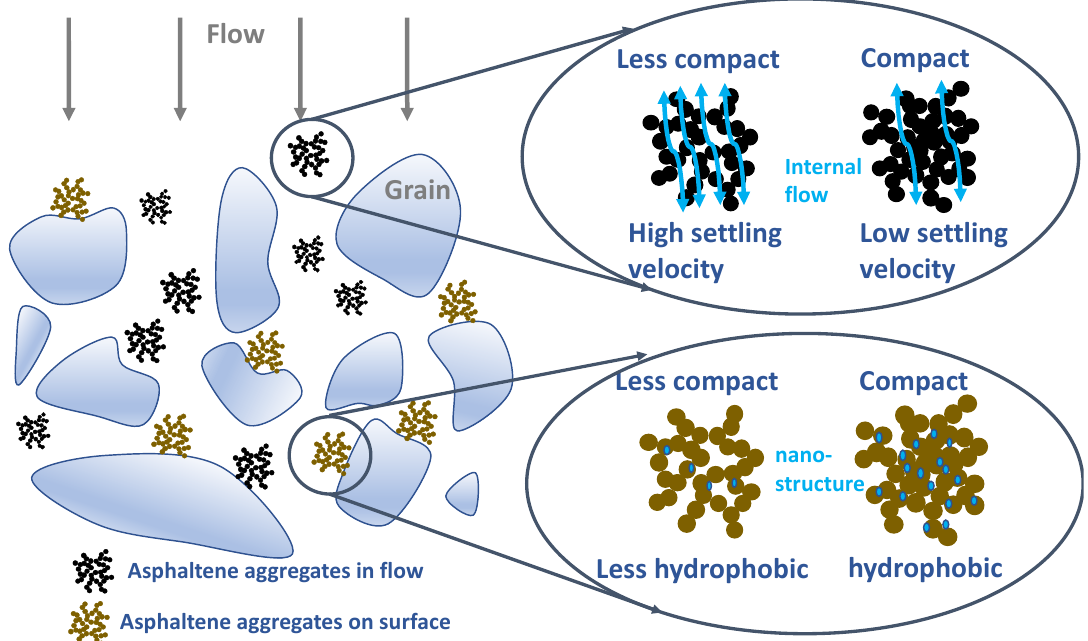
Figure 5. Schematic of the proposed asphaltene aggregates structure e ff ects on settling velocity and wettability of aquifer surface, and associated implications for in situ remediation of sites contaminated with heavy